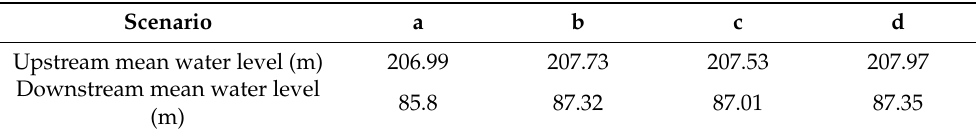
Table 6. Comparison of mean water level of selected upstream and downstream cross section for different scenarios: ( a ) current period; ( b ) 2040–2069 under RCP8.5 from CCDP; ( c ) 2030–2070